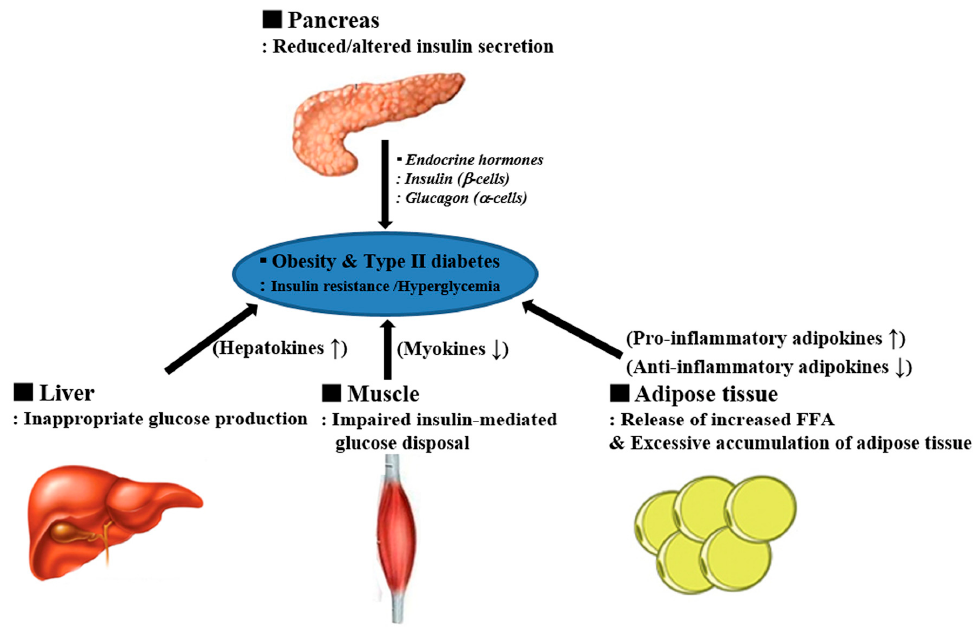
Figure 1. Obesity and type II diabetes are characterized by insulin resistance in peripheral tissues. Under insulin-resistant conditions, impaired insulin action enhances hepatic glucose production. Obese adipose tissue secretes adipokines that induce a pathogenic and pro-inflammatory environment. hepatokines. FFA: free fatty